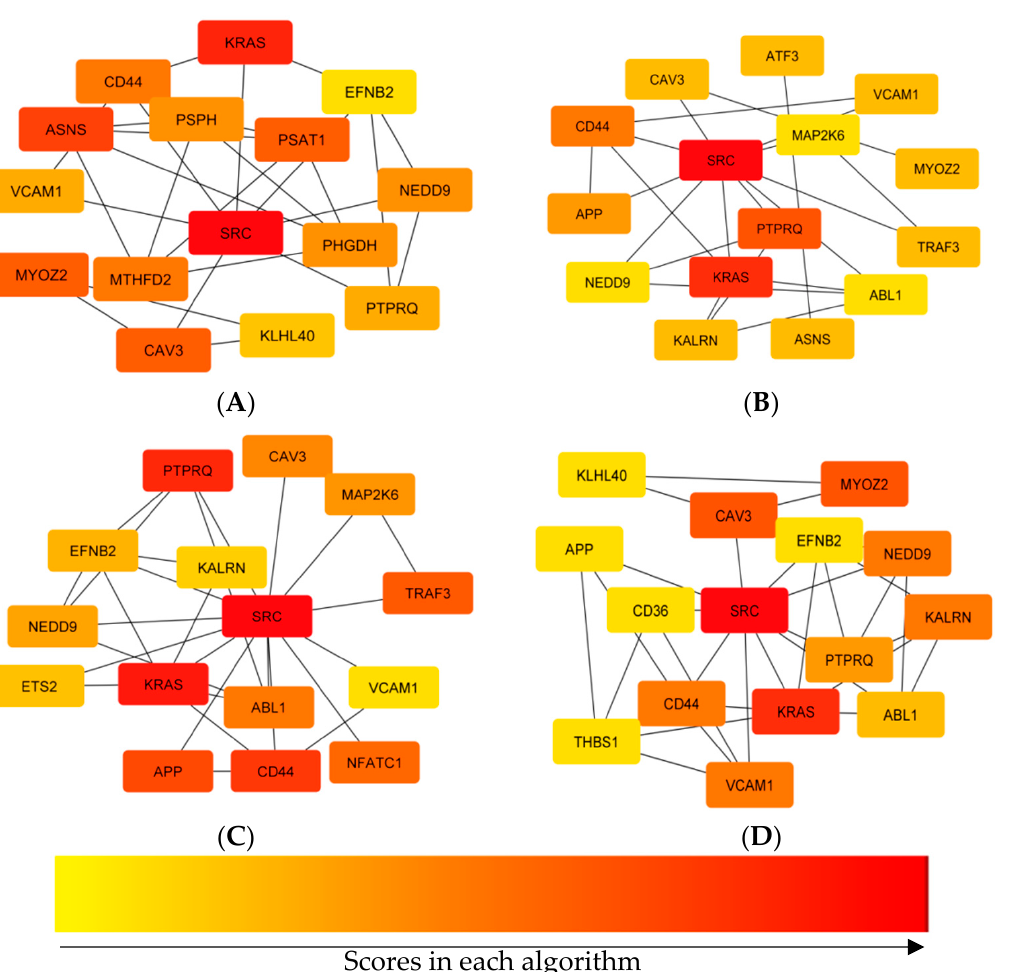
Figure 4. Comparing hub genes that were identified using four centrality algorithms of CytoHubba.